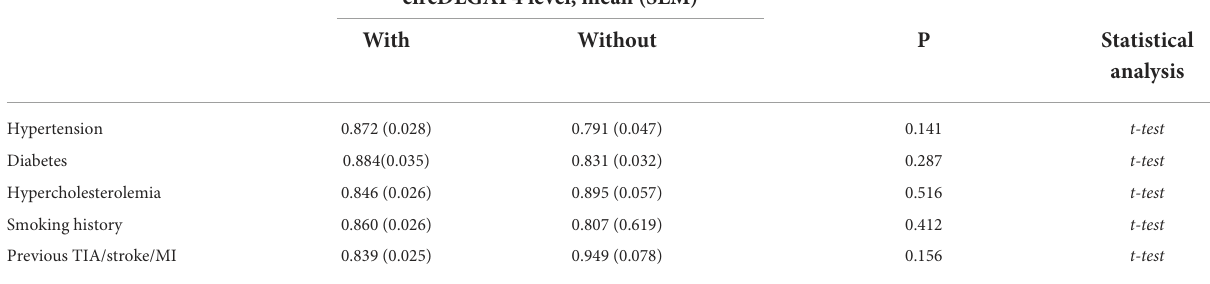
TABLE 2 The circDLGAP4 level in all samples with or without vascular risk